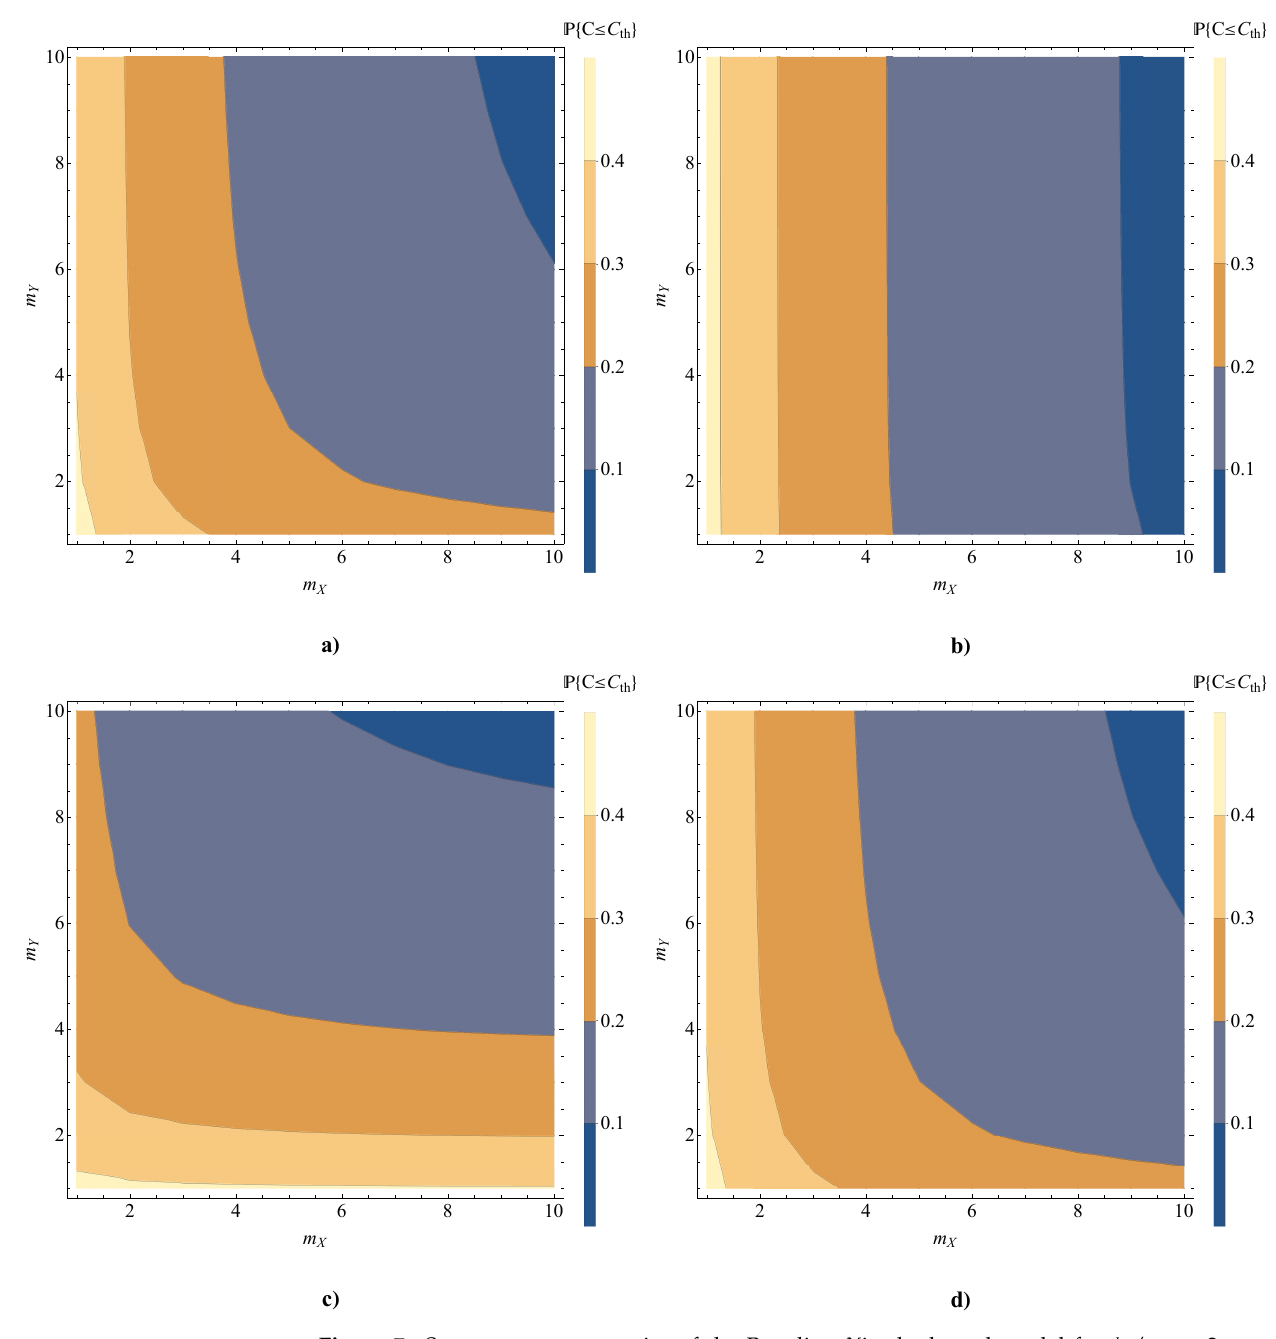
Figure 7. Secrecy outage capacity of the Beaulieu–Xie shadowed model for d W / d C th = 0.5, and ¯ γ M = 5 dB with: ( a ) Ω X = − 5 dB, Ω Y = − 5 dB; ( b ) Ω X = 5 dB, Ω Y = − 5 dB; ( c ) Ω X = − 5 dB, Ω Y = 5 dB; ( d ) Ω X = 5 dB, Ω Y = 5